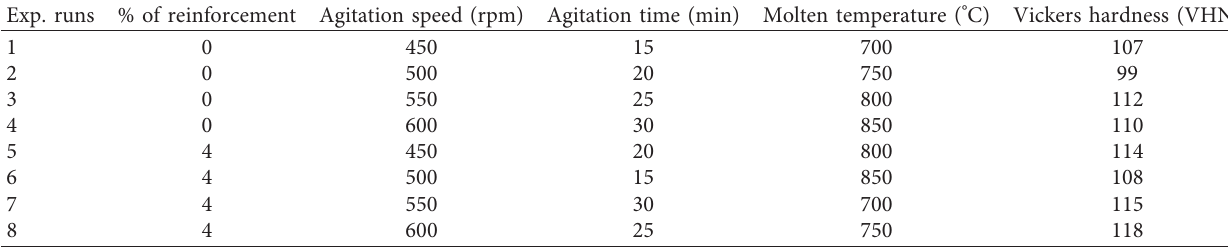
Table 7: Experimental summary of Vickers hardness